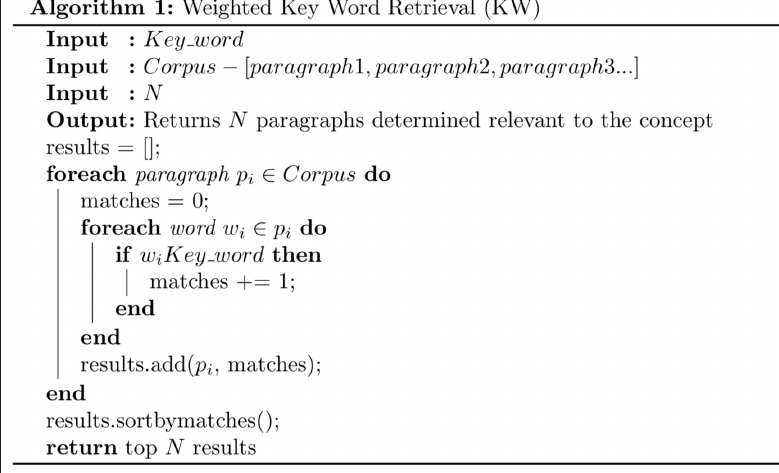
Figure 2: Key Word Retrieval